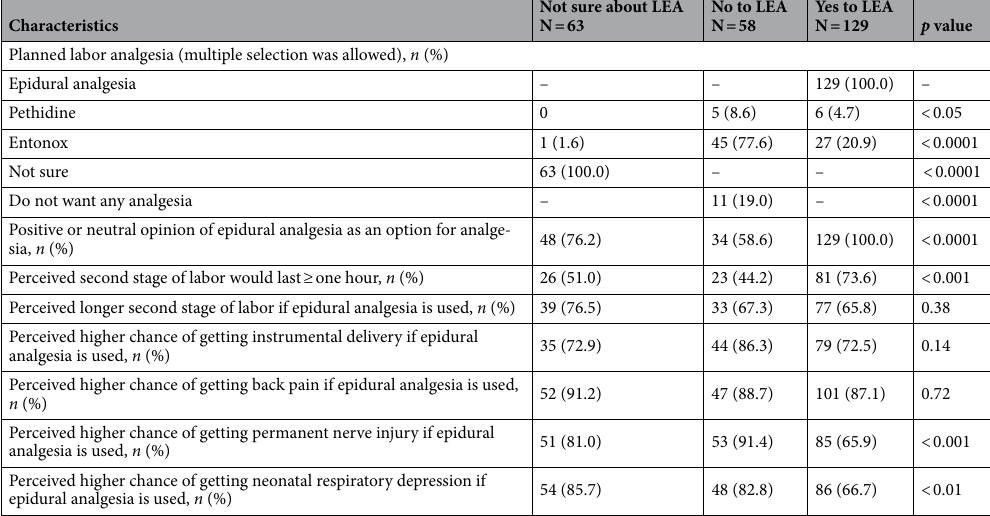
Not sure about LEA N =